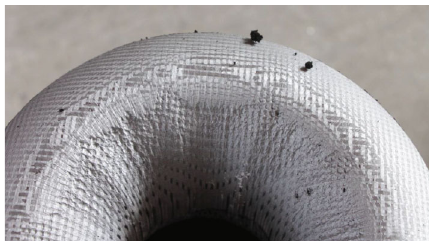
Figure 12: Throat insert after the ground hot fi ring